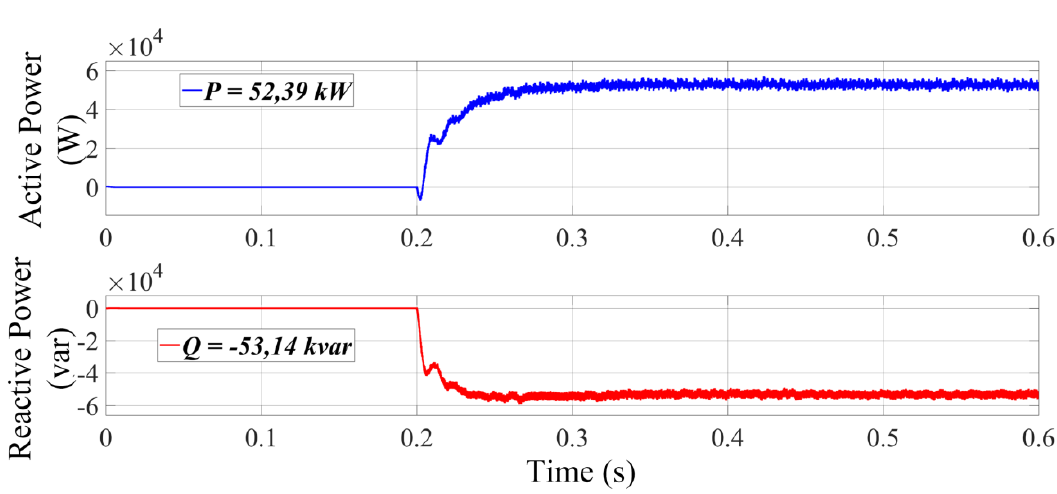
Figure 15. Voltage (upper, 10 kV/div) and current (lower, 5 A/div) imposed to TUT, F p = 0.7 capacitive. Horizontal axis: 5 ms/div.